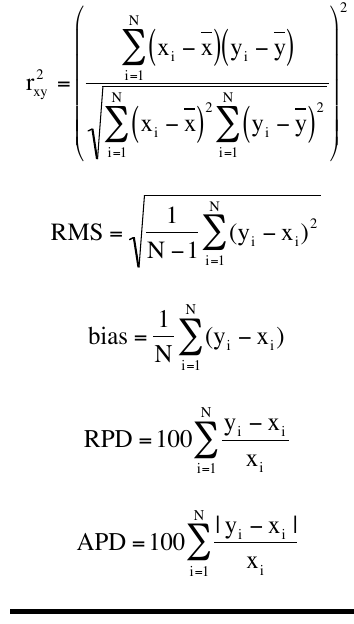
Table 2: Basic statistical quantities used for the assessment of satellite (y) data using 746 in situ (x) space-time co-located observations. N represents the total number of 747 matchup points. The correlation coefficient (r 2 ) is dimensionless, root mean square 748 (RMS) and bias have the same dimensions as x (in situ observations) and y (satellite 749 measurements), and relative (RPD) and absolute (APD) differences are expressed as 750 percent. 751